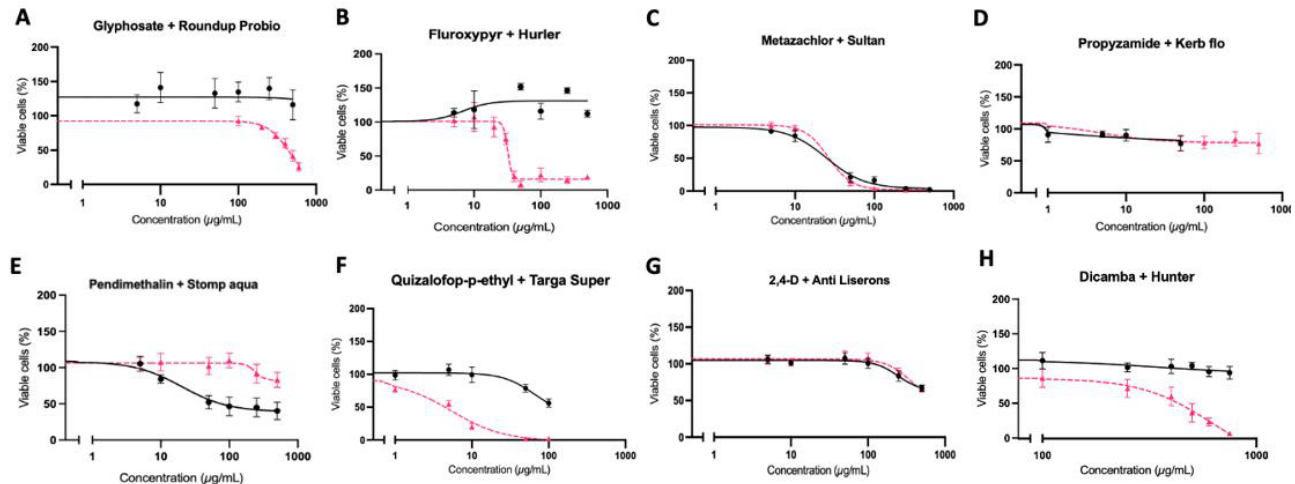
Figure 1. Differential cytotoxicity of herbicide active principles and their representative corresponding commercial formulations on human hepatocyte HepG2 cells using an MTT assay. Concentrations in µg/mL are dilutions of each active ingredient (black line) and formulation (pink line). The standard error of the mean (SEM) is shown in all instances (n = 15).